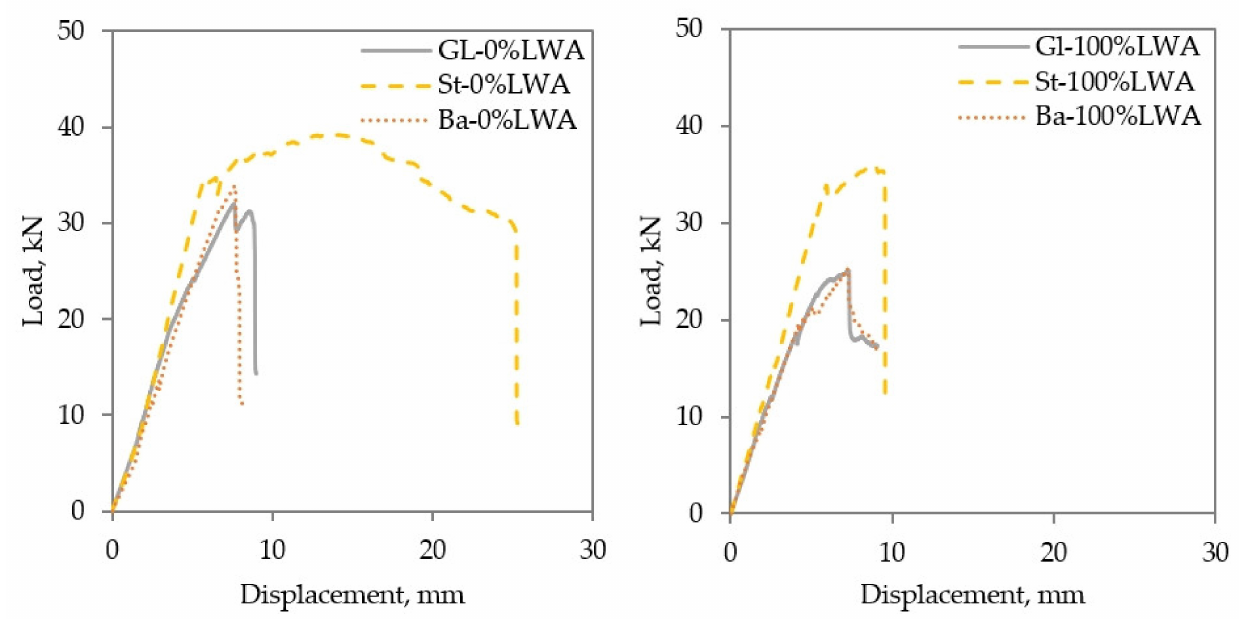
Figure 9. Effect of type of reinforcing bar on the load–displacement relationship of ( left ) normal weight concrete and ( right )